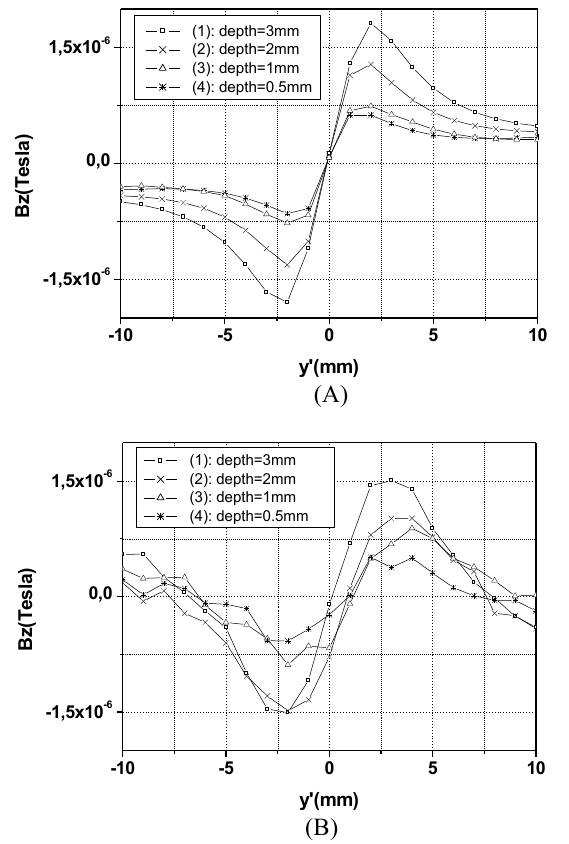
Figure 11: Comparison of theoretical (A) and measurement in the case of a (B) values of the component field 𝐵 ! calibrated crack in the center, for four different values of the crack depth ((1): 3mm, (2): 2mm, (3): 1mm and (4): 0.5mm) If we compare the measurement results obtained in the four cases, we see that the shapes of the component field 𝐵 ! curves are totally identical and tally very well with the corresponding theoretical